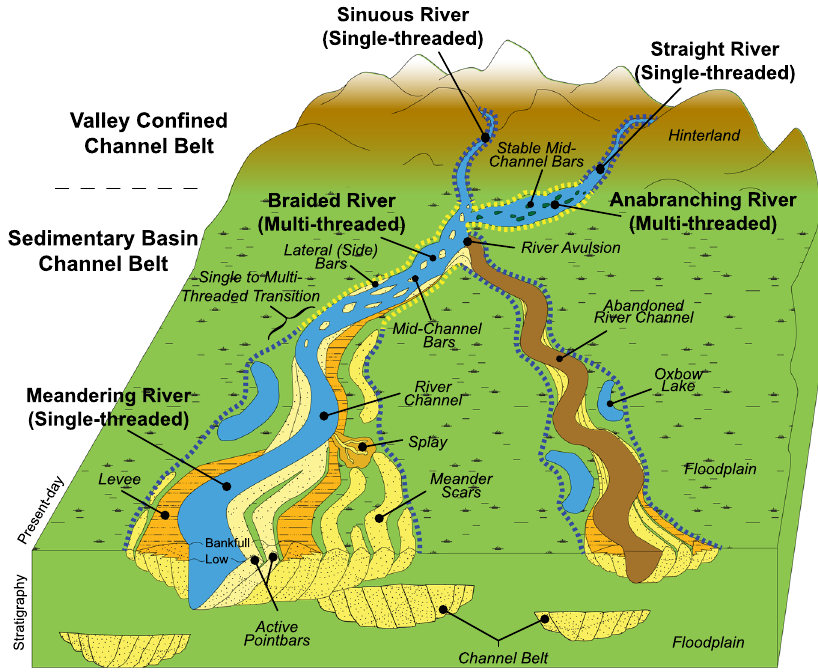
Fig. 1 | Channel belt Terminology — schematic illustration of the channel belt extent that include the encompassing area of straight, sinuous, meandering, braided and anabranching river channels (active and abandoned) and its associated levees, bars, and overbank landforms. The current Global Channel Belt model de fi nes the observable extent of channel belts based on 30m Landsat